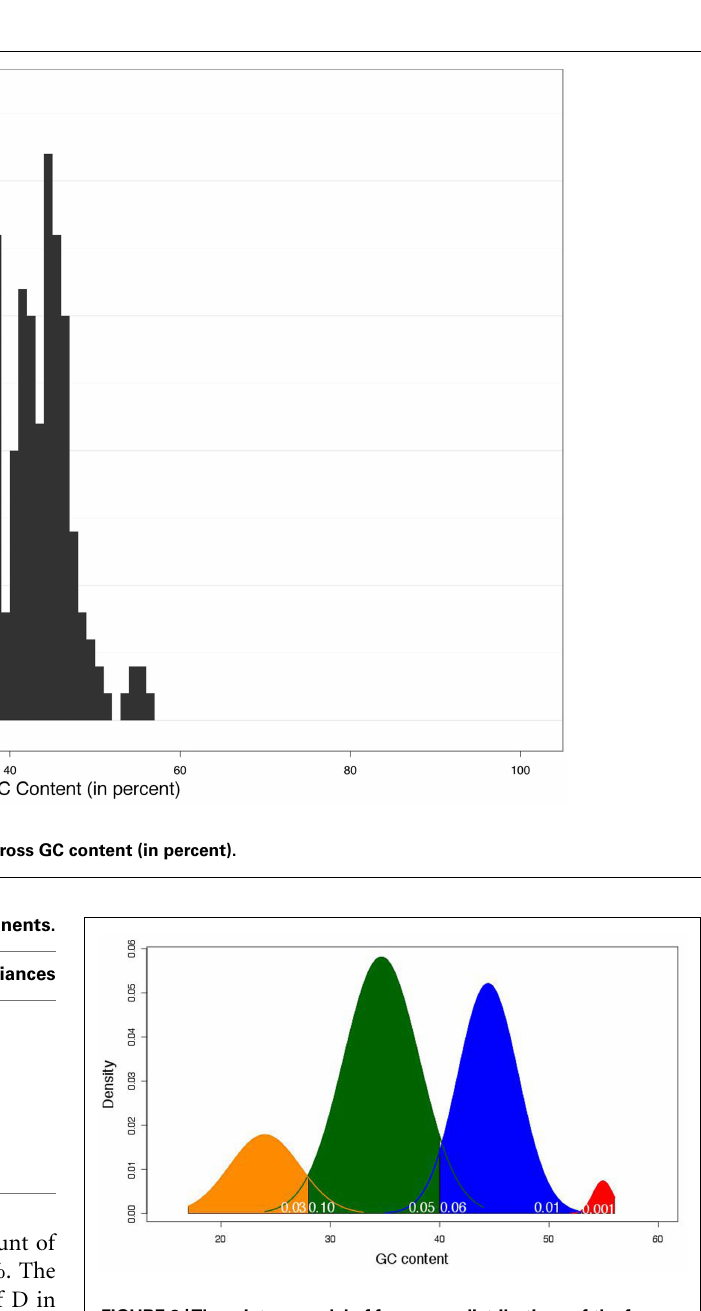
FIGURE 2 |The mixture model of frequency distributions of the four LHGR families across GC content (in percentage). The different colors represent the different families.Yellow is Family A, green is Family B, blue is Family C, and red is Family D.The numbers in white at the base of the density distributions represent the amount of the overlap estimated to come from the adjacent family. For example, the 0.03 value at the base of Family A (yellow) indicates the amount of that family’s distribution that may be attributed to Family B